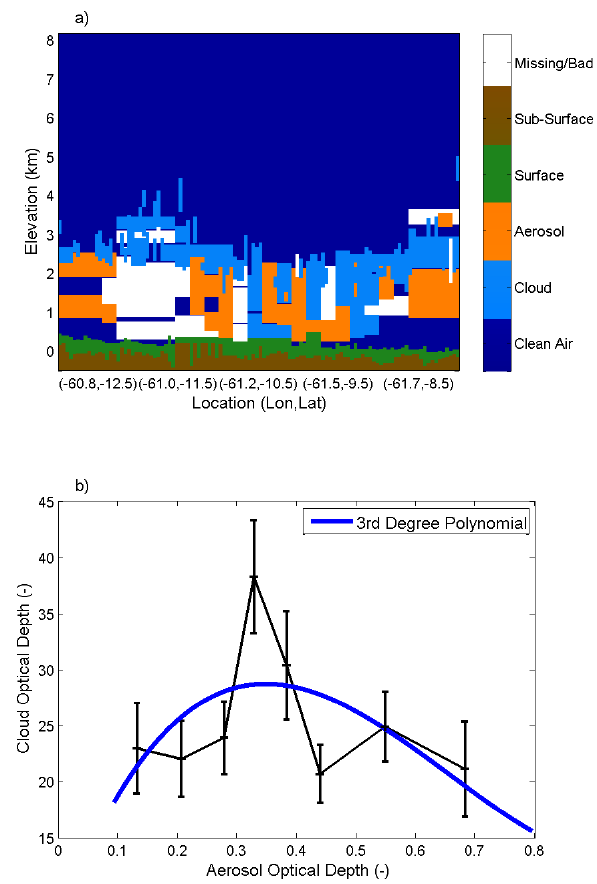
Fig. 7. (a) Vertical Feature Mask from the CALIPSO lidar on a path through the study region for a single day during the study pe- riod, 12 August 2006. On this day, clouds mostly form near the top of the aerosol layer. Clouds that extend throughout the column could be misclassified heavy aerosol plumes, however, we use only medium to high quality data to minimize misclassification. (b) Liq- uid cloud optical depth binned by aerosol optical depth on the same day as in (a) , throughout the 5 ◦ × 5 ◦ study region for cloud top pressures between the 5th and 50th percentiles (784mb–845mb). The 5th percentile refers to the height of the highest 5% of warm clouds and the 50th percentile is the median height of warm clouds. Low clouds likely embedded within the aerosol layer are removed ( > 50th percentile) in addition to high clouds which may be above the influence of aerosols ( < 5th percentile), leaving 167 retrievals for analysis ( ∼ 21 retrievals per bin). A least squares third-degree polynomial that best fits the pre-binned data is also